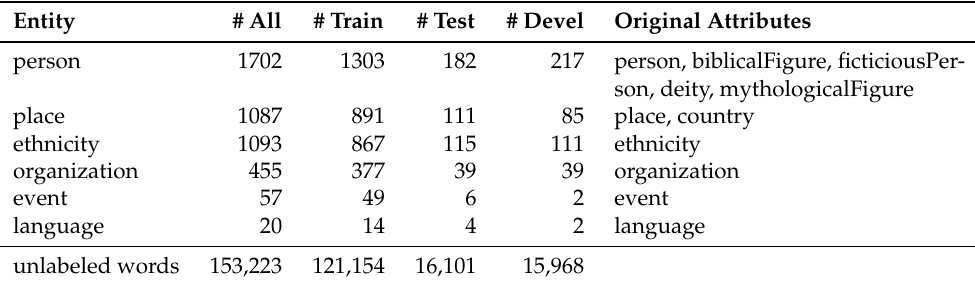
Table 1. Distribution of NER entities in H.Arendt Edition. Column “Original attributes” lists which attributes from the original TEI files were combined into one “Entity” for the NER dataset. On average, an entity consists of 1.36 words.